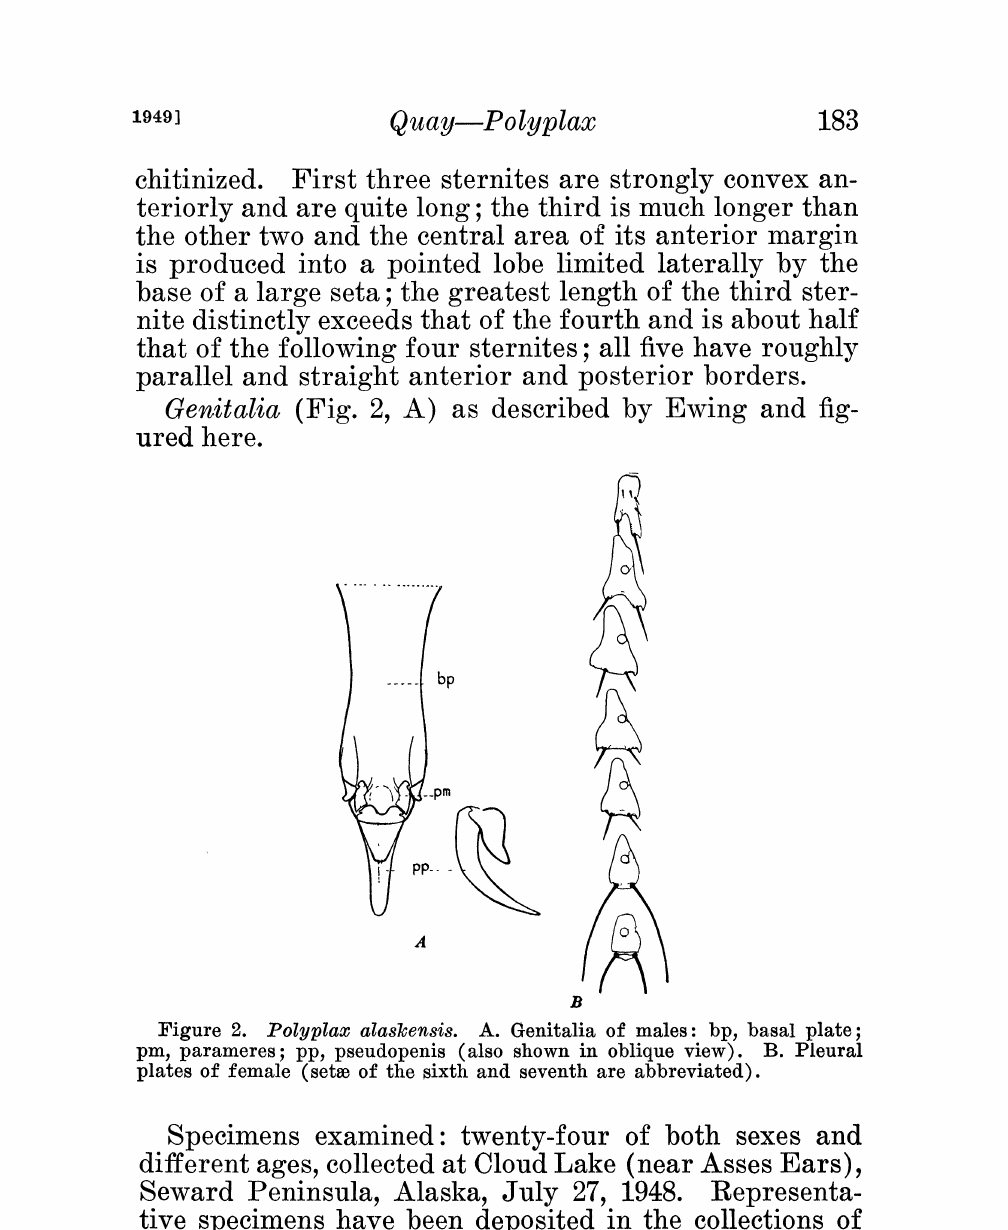
Figure 2. Polyplax alaslensis. A. Genitalia of males: bp basal plate; pro, parameres; pp, pseudopenis (also shown in oblique view). B. Pleural plates of female (setm of the sixth and seventh are